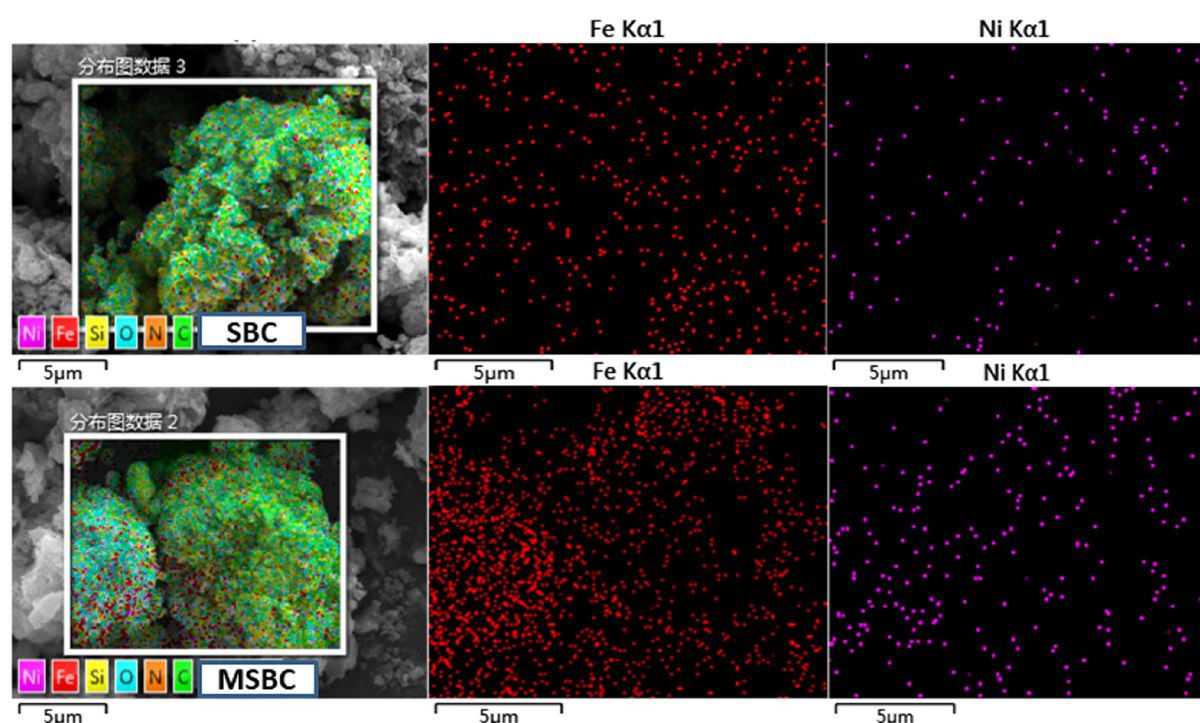
Fig 1. SEM-EDX analysis on the surface of SBC and MSBC after Ni adsorption.